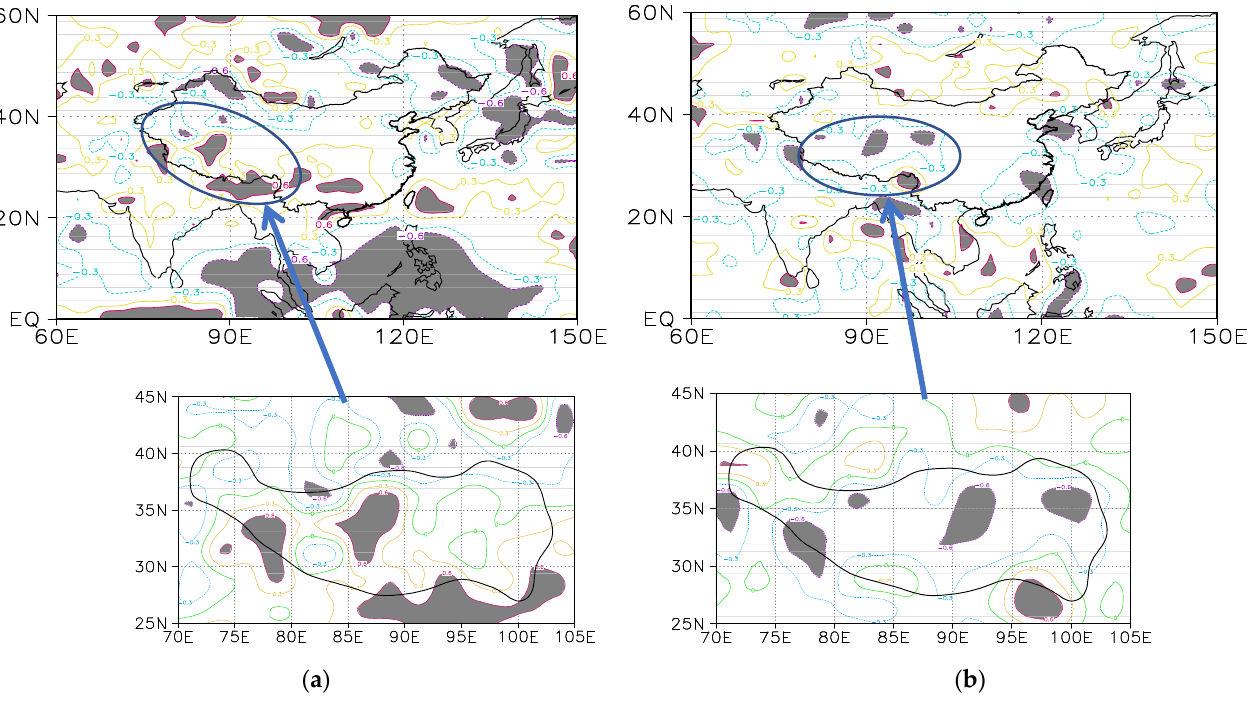
Figure 8. Correlation of STA index Z with ( a ) winter precipitation rate and ( b ) summer precipitation rate in East Asia. Shading indicates the anomaly regions that reached a 0.1 significance level; the contour interval is 0.5%. (Units: lati- tude is ° N , and longitude is °